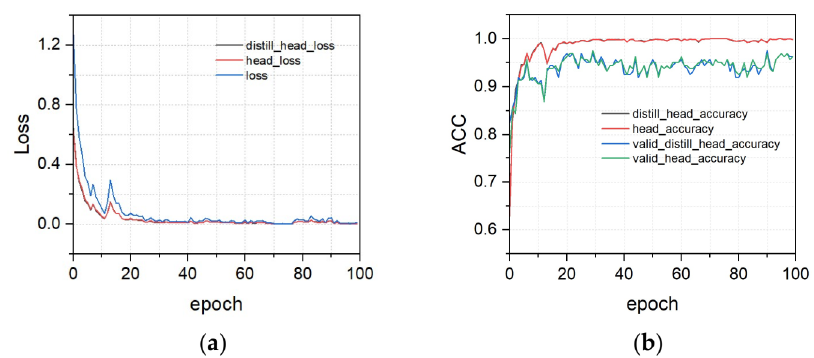
Figure 12. Training curves of Crack500. ( a ) Loss curves of two classifier heads, ( b ) Training curves of training and validation